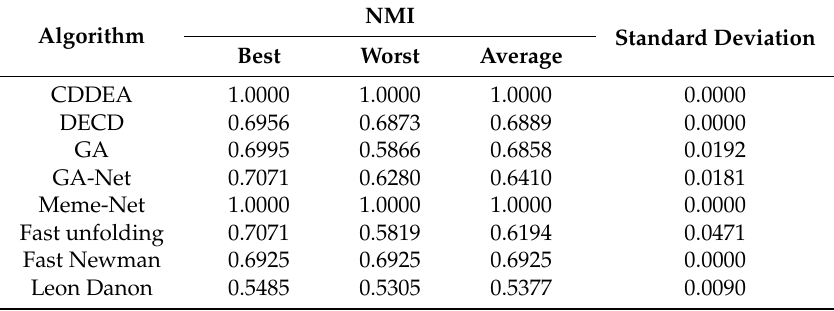
Table 2. Normalized mutual information (NMI) result obtained using eight algorithms on Zachary’s karate club network.